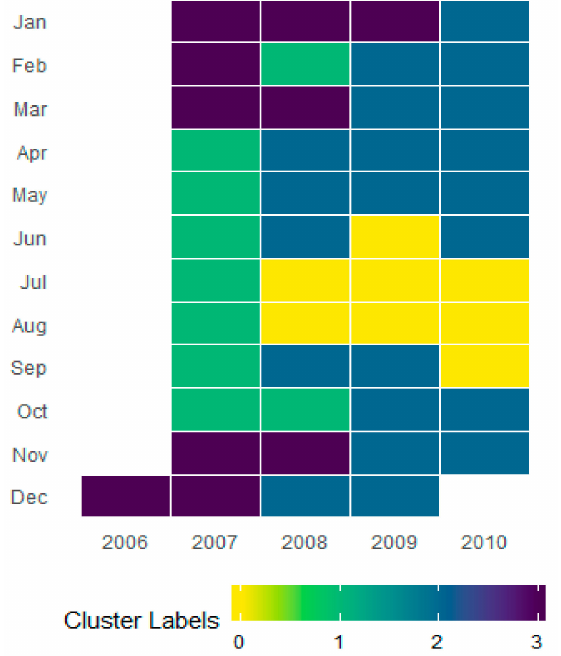
Figure 7. Monthly electricity energy consumption patterns captured in di ff erent clusters for the individual household